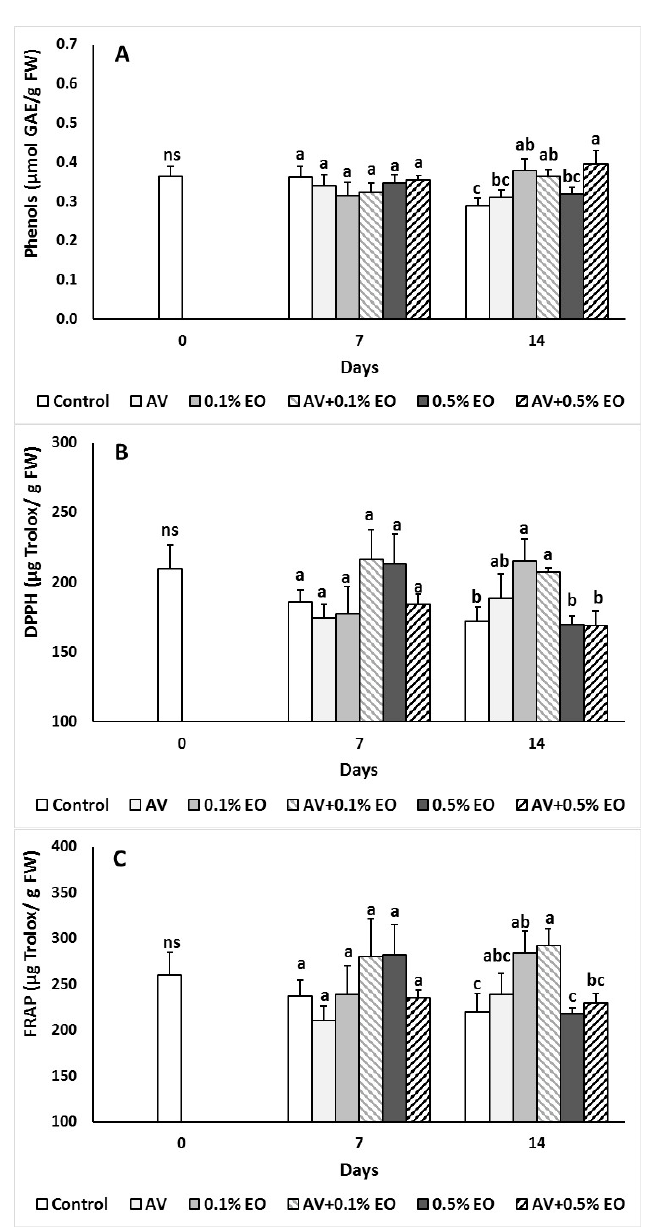
Figure 5. Impacts Aloe vera (AV at 10%) coating and/or sage essential oil (EO at 0.1% and 0.5%) on ( A ) total phenolics ( μ mol GAE/g FW) and antioxidant activity (mg Trolox/g FW) of ( B ) DPPH and ( C ) FRAP in tomato fruit following storage for 7 and 14 days. Fruit were maintained throughout at 11 °C and 90% RH. Values represent mean (±SE) of measurements made on eight independent fruit per treatment and storage period. On the columns, significant differences ( p < 0.05) among treatments are indicated by different Latin letters for different days. Symbols of * or ns indicating significance or not, respectively, among controls through storage period.